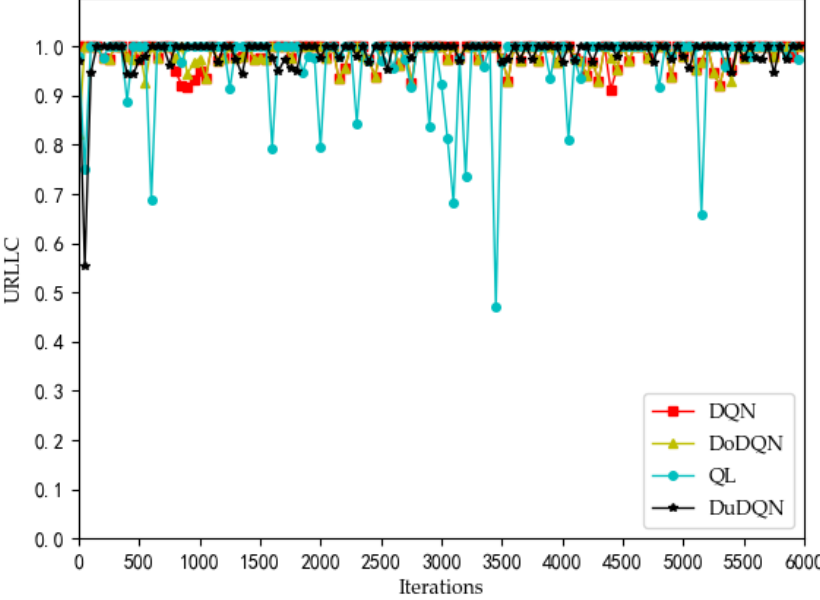
Figure 8. Comparison of QoE of URLLC using different methods (taking MVNO-1 as examples).